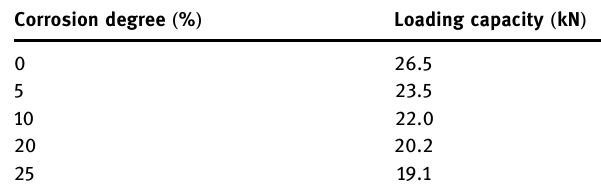
Table 6: Loading capacity of RC beams based on